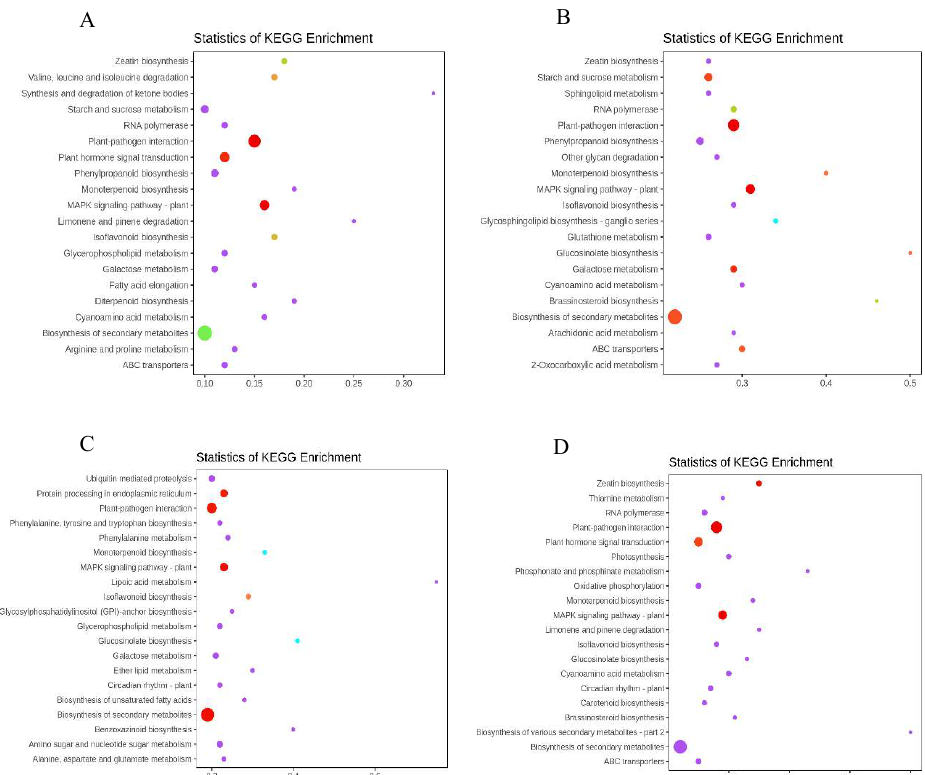
Figure 5. KEGG enrichment analysis of DEGs in A. pseudosieboldianum under freezing stress at different temperatures. KEGG pathway classification of DEGs of A. pseudosieboldianum under low-temperature stress at different temperatures and CK group control, respectively. The y -axis corresponds to the KEGG pathway, the x -axis indicates the number of DEGs enriched in a pathway between the enrichment rate. The color of the dot represents the q-value and the size of the dot represents the number of DEGs mapped to the reference pathway. A larger rich factor indicates a greater enrichment. A smaller q-value indicates a more significant enrichment. ( A ) is the KEGG enrichment analysis of DEGs between APCK (4 °C) and APA (−10 °C), ( B ) is the KEGG enrichment analysis of DEGs between APCK (4 °C) and APB (−20 °C), ( C ) is the KEGG enrichment analysis of DEGs between APCK (4 °C) and APC (−30 °C), ( D ) is the KEGG enrichment analysis of DEGs between APCK (4 °C) and APD (−40 °C).